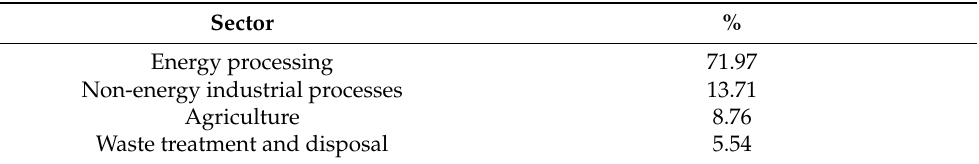
Table 8. Distribution of CO 2 emissions in Catalonia by sector. Source: Catalonia Climate Change Office